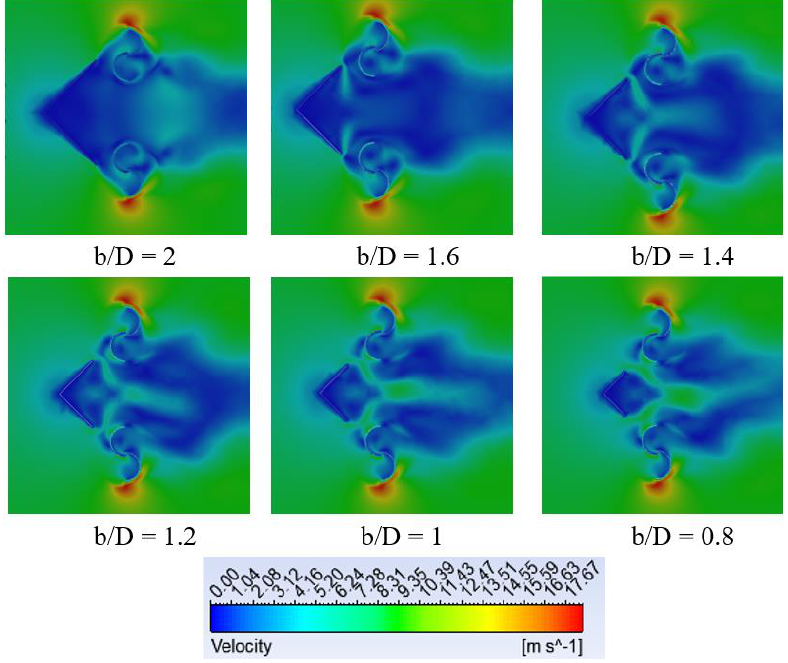
Figure 13. The effect of triangular plate base width with velocity contours.